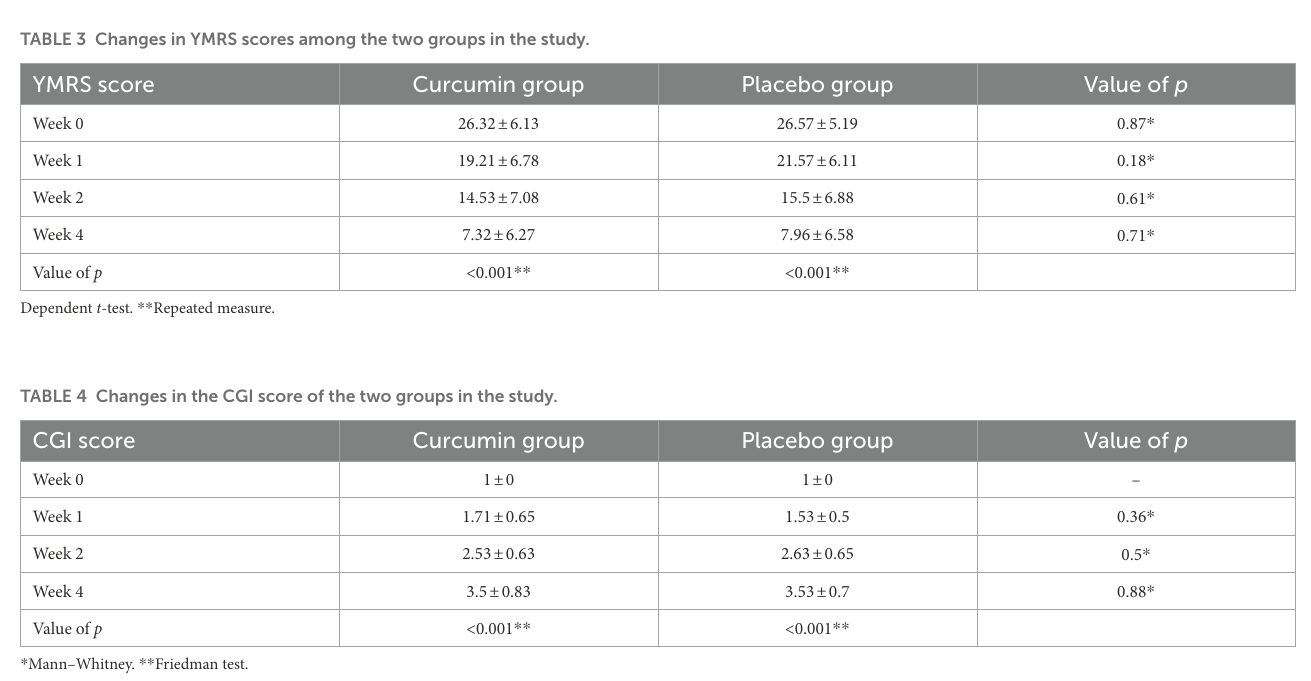
TABLE 3 Changes in YMRS scores among the two groups in the study. YMRS score